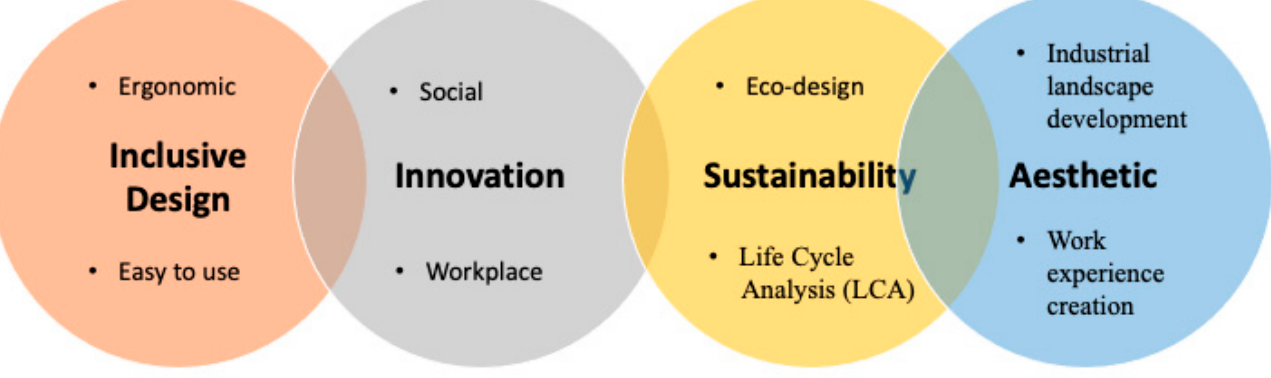
Figure 1. Premises of the practical work of the subject.